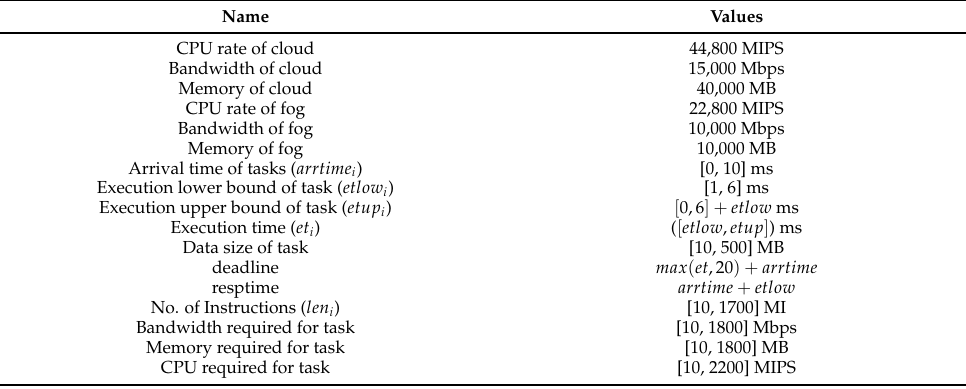
Table 5. Resource configuration of cloud–fog infrastructure and